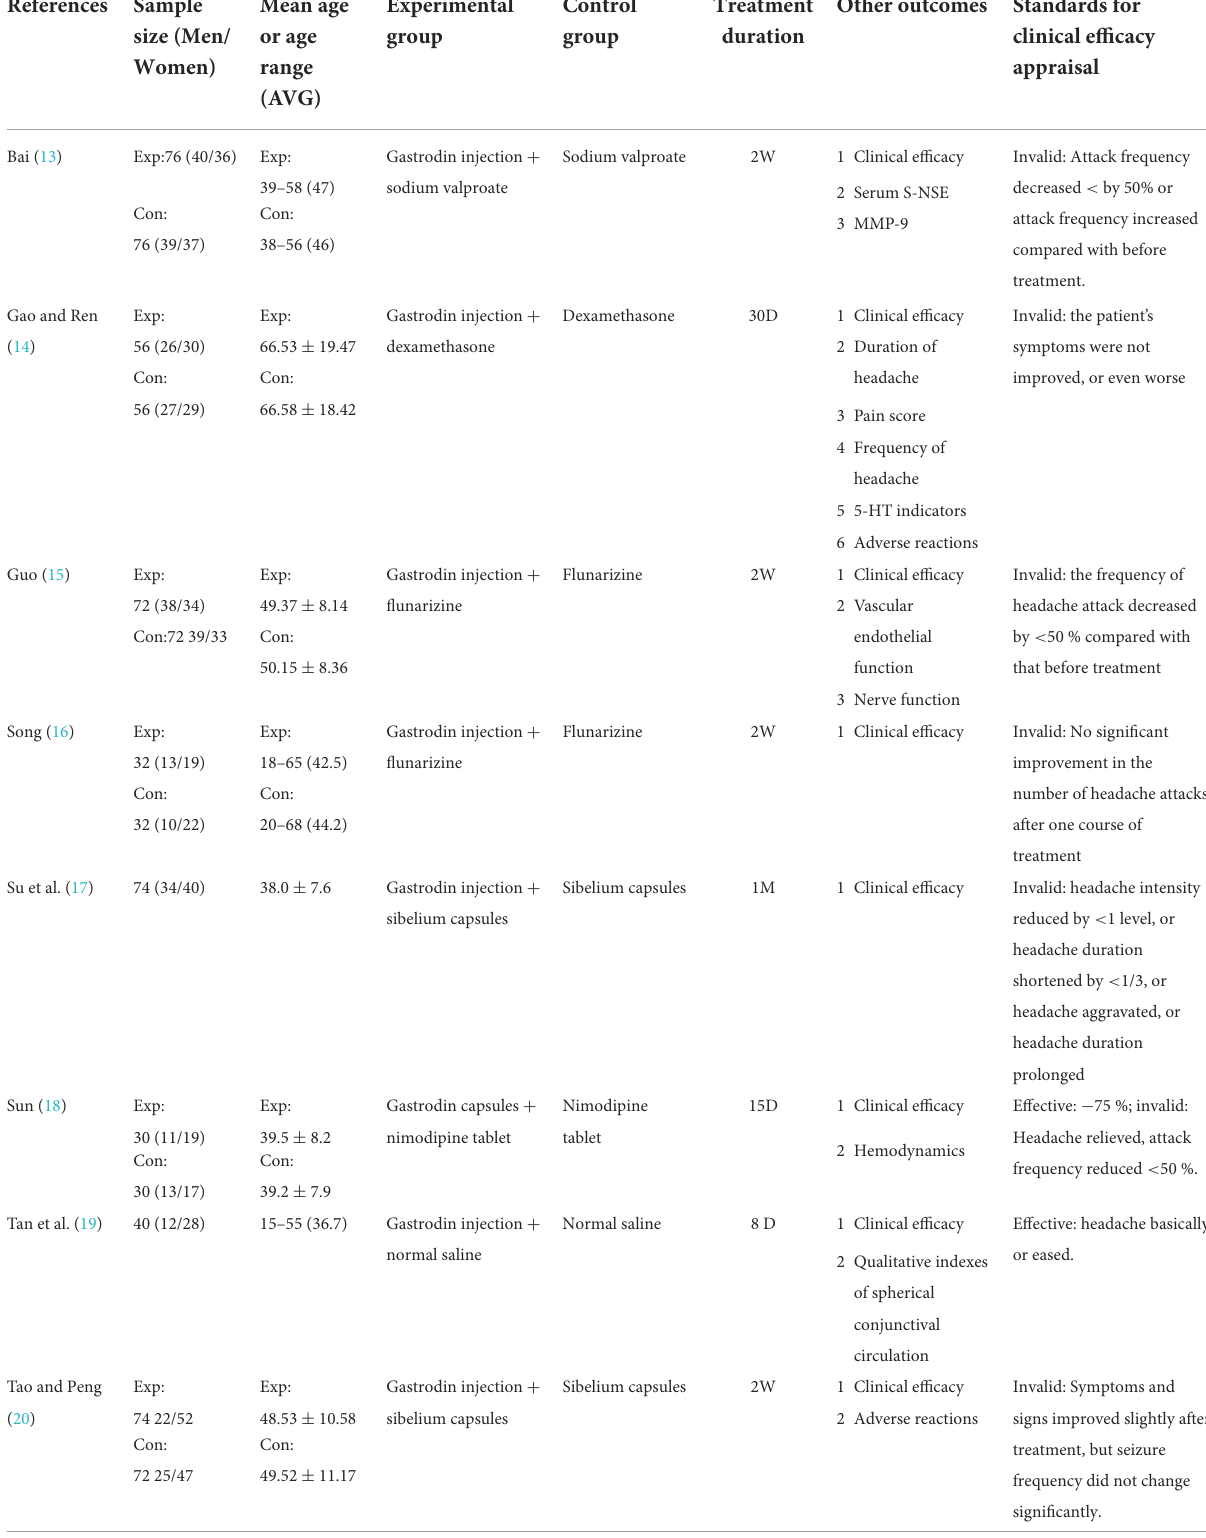
TABLE 1 Basic characteristics of research literature